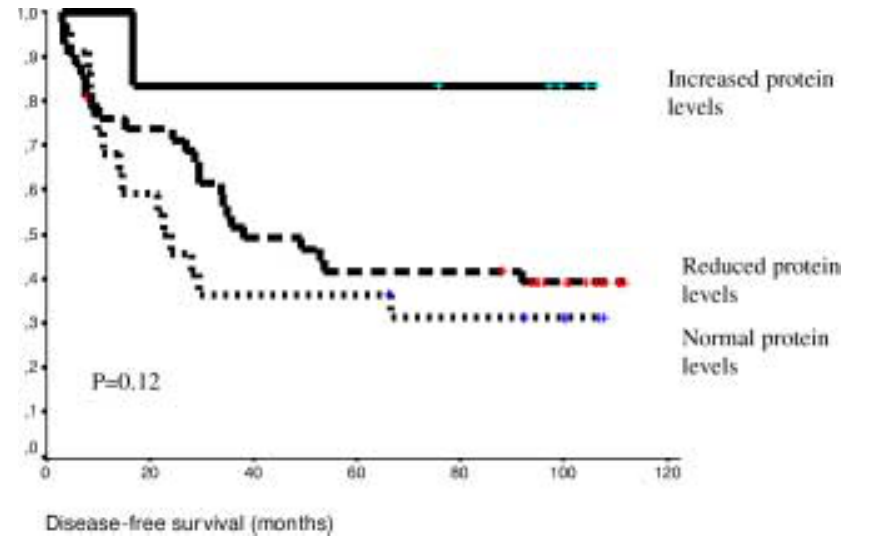
Fig. 3. The univariate analysis shows that overpression of FGFR3 protein is related to a better prognosis, although not statistically